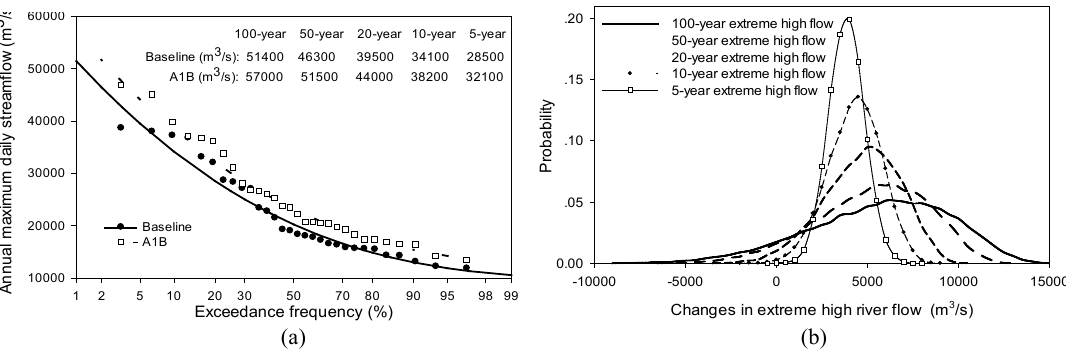
Fig. 7 Pearson type III plots of annual maximum daily discharge under baseline and A1B scenarios (a) and frequency distribution of possible predicted changes in extreme high flow at various return periods